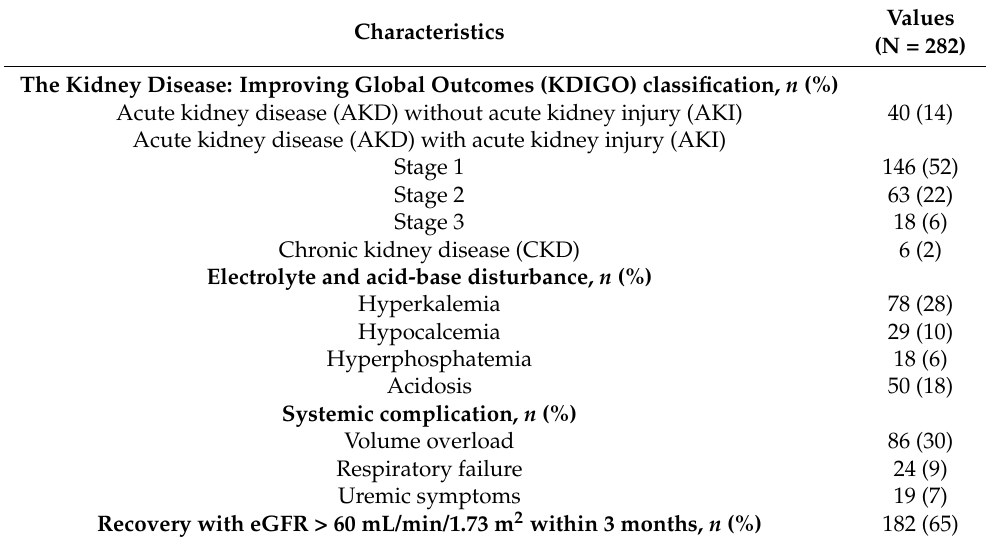
Table 2. Characteristics of 282 patients with